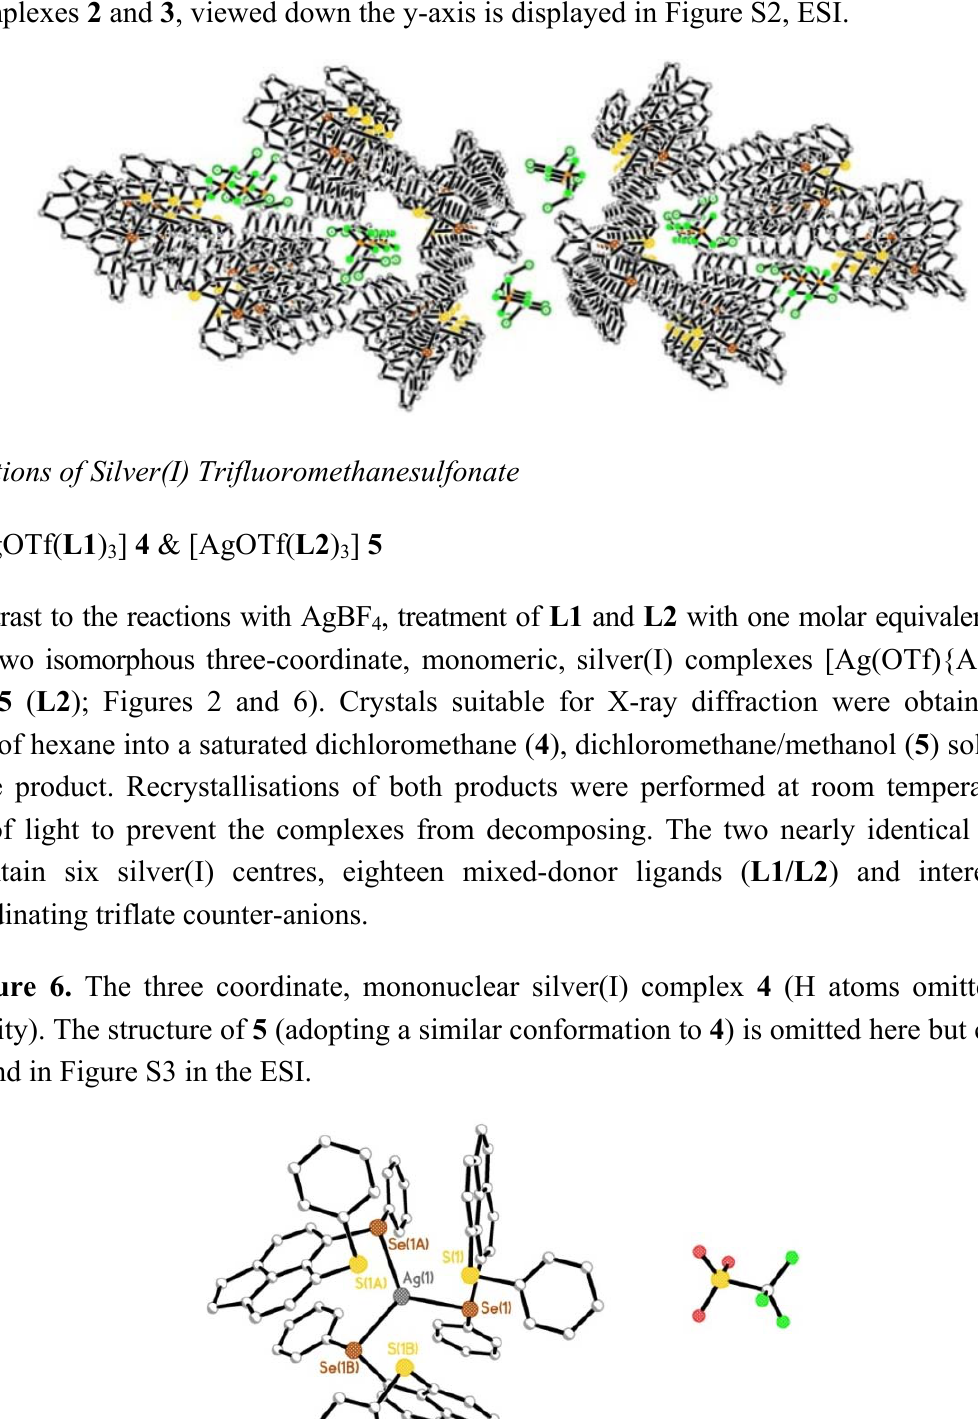
− counter-anions and dichloromethane 4